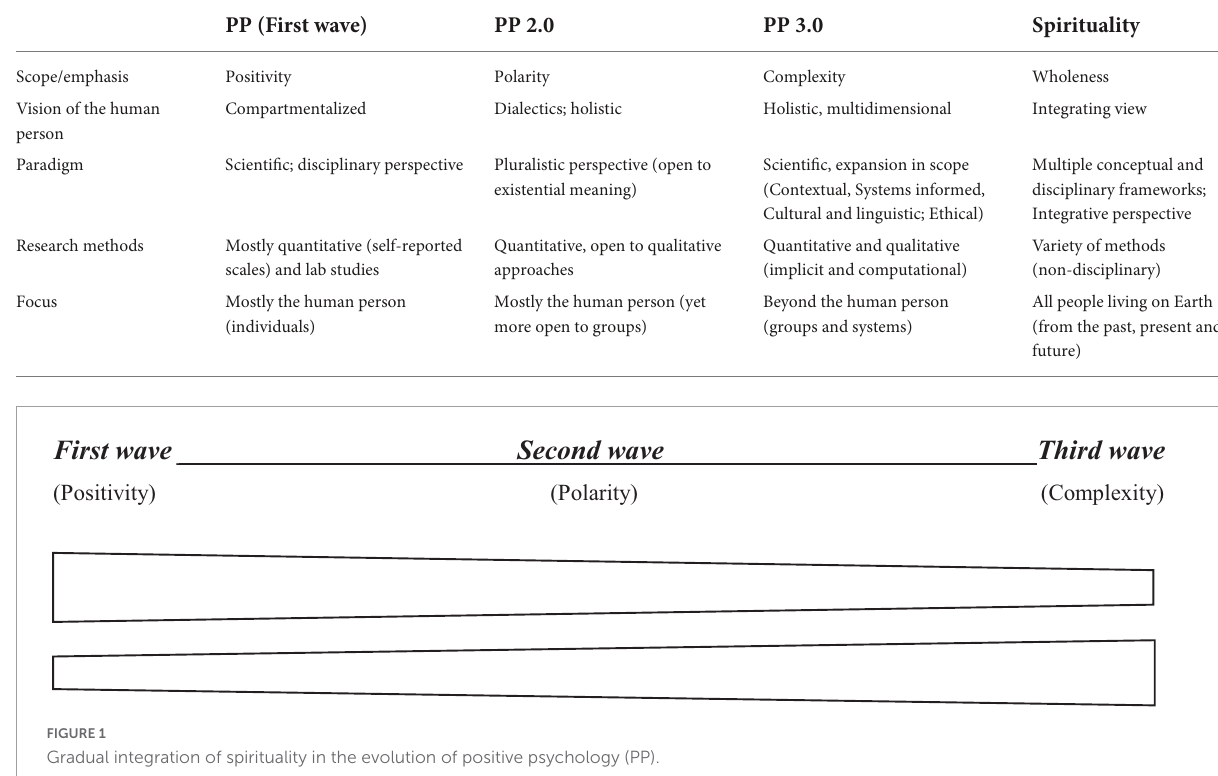
TABLE 1 Epistemological considerations concerning the three waves of positive psychology (PP) and spirituality.